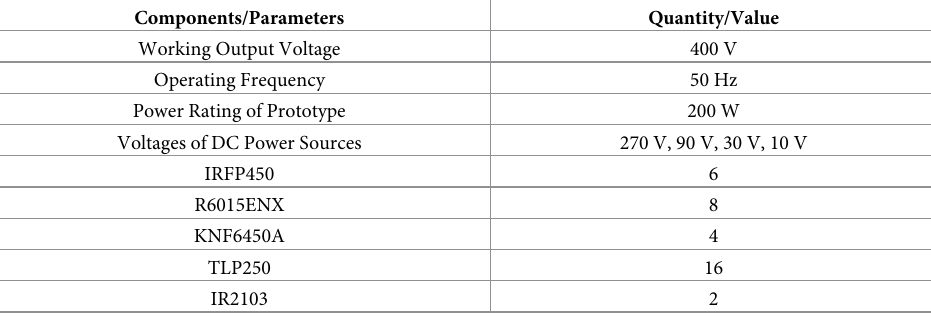
Table 2. Parameters and main components used for hardware prototype